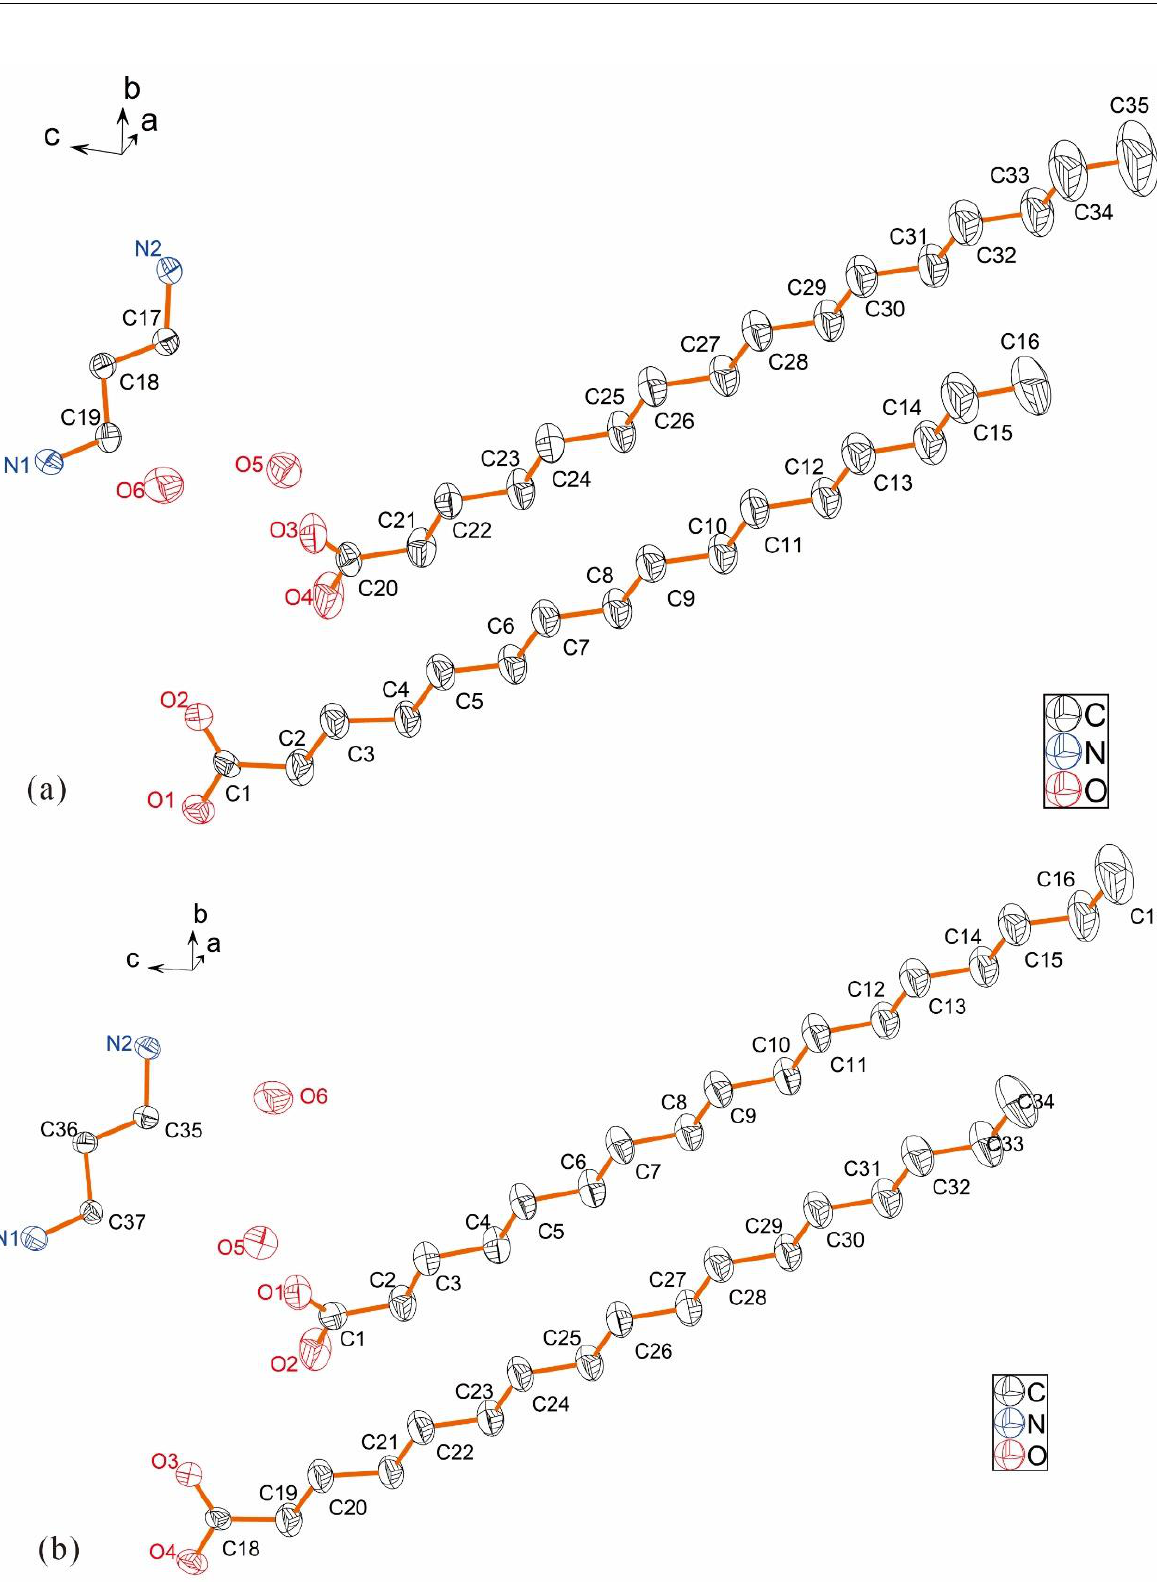
Figure 1. Ellipsoid diagrams of molecular structure of the two molecules: where ( a ) represents 3C16 and ( b ) represents 3C17.